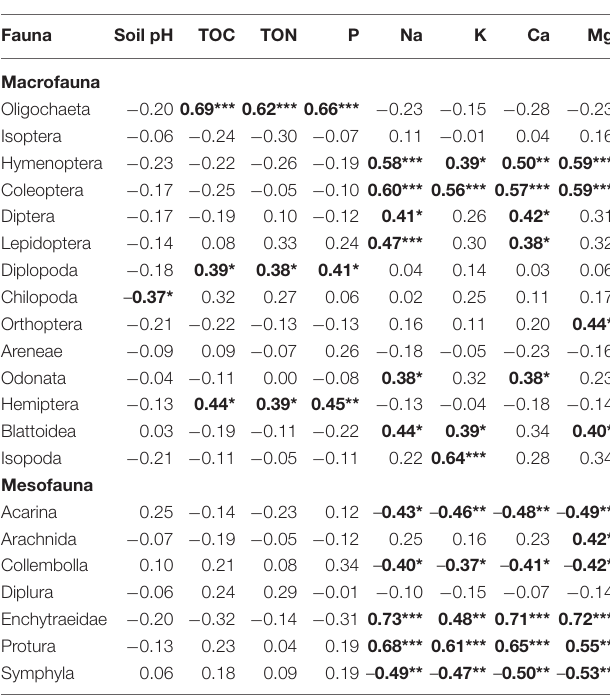
TABLE 7 | Pearson correlation matrix of soil fauna and soil